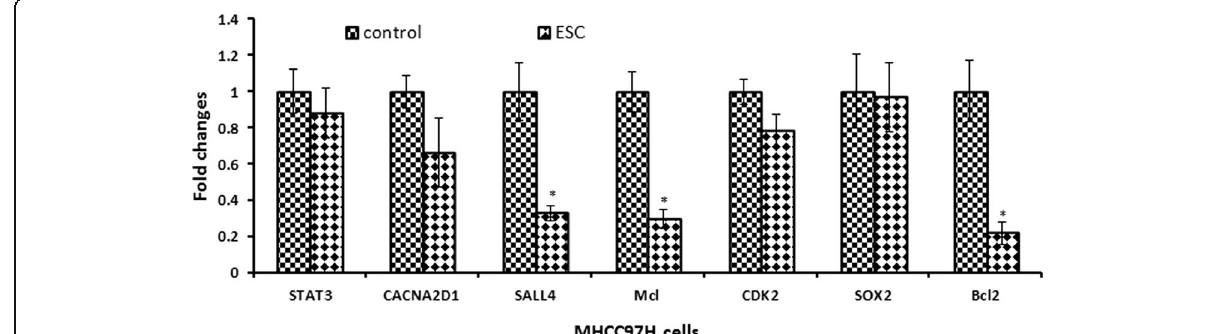
Fig. 5 Evaluation of the expression level of target genes. Target genes STAT3, CACNA2D1, SALL4, MCL1, CDK2, SOX2 and Bcl2 of miRNAs were validated with real-time PCR in MHCC-97H cells. ESC could significantly downregulate SALL4, McL-1 and Bcl-2 genes that has-miR-107 targeted in MHCC-97H cells. *p < 0.05, **p < 0.01 vs